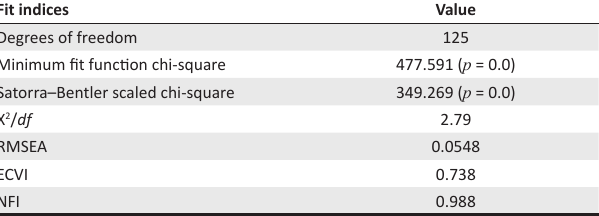
TABLE 4: Fit indices of the measurement model.